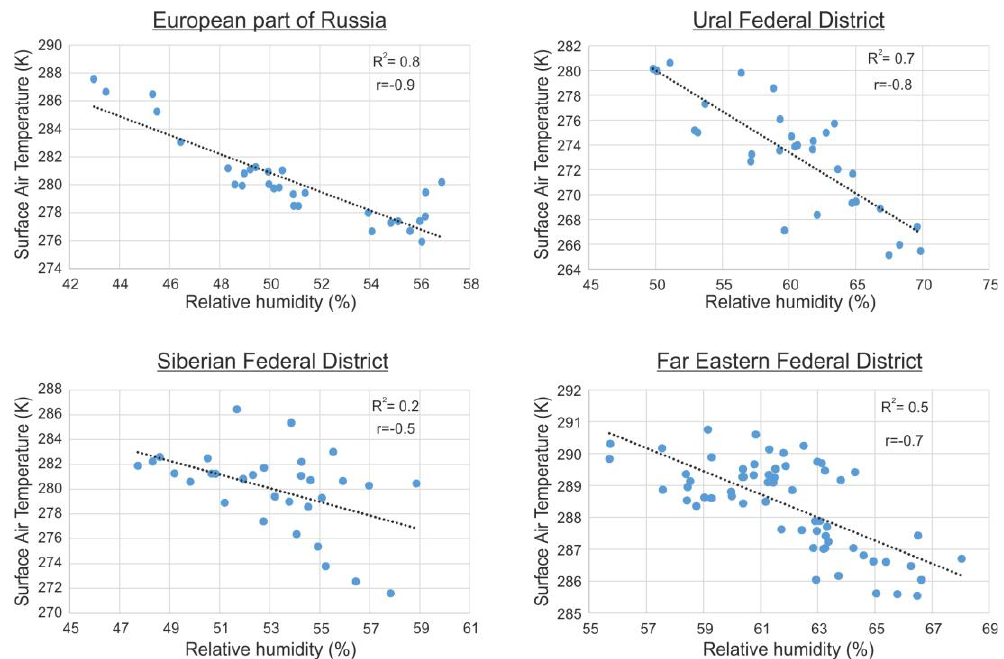
Figure A1. Graphs of correlation between surface air temperature and relative humidity.